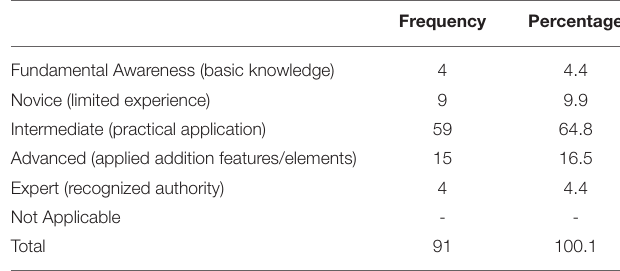
TABLE 4 | The rate of USIM staff skills in e-Learning.